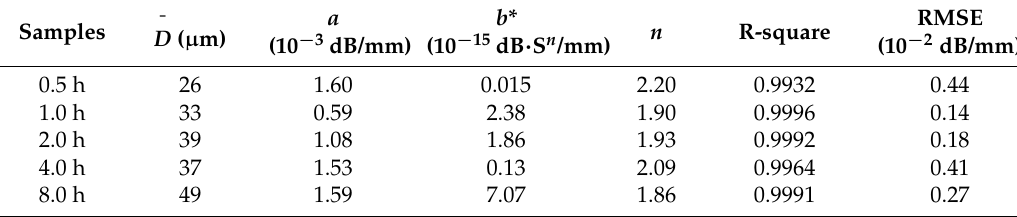
Table 2. Fit parameters of the approximate evaluation function α ( f ) = a + bD n ‐ 1 f n with 𝑏 ∗ (cid:3404) bD (cid:3365) n ‐ 1 obtained from the attenuation vs. frequency data in Figure 7.